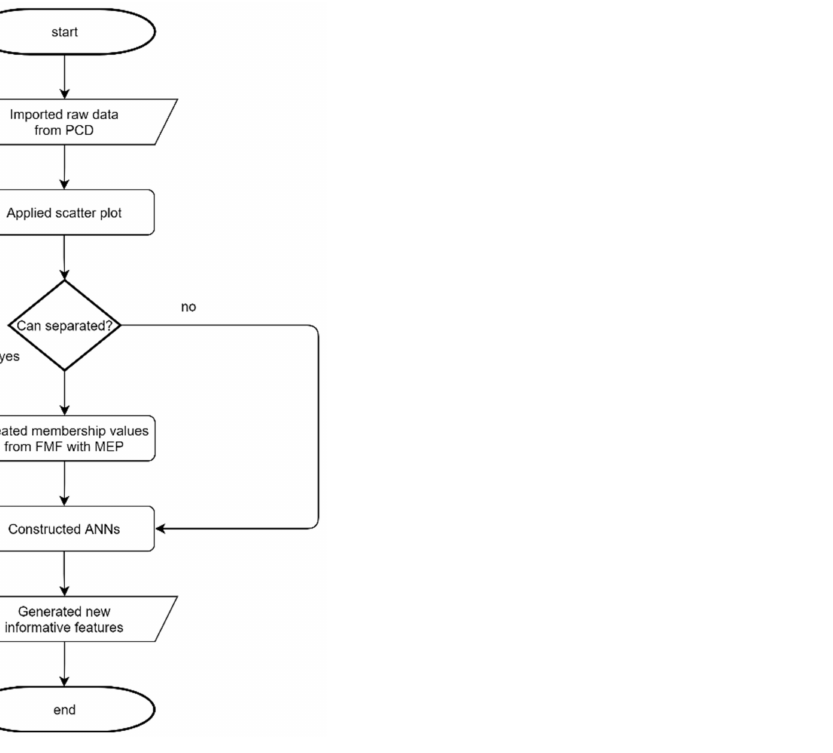
Figure 1. The flowchart of the neuro-fuzzy transformation with the minimum entropy principle